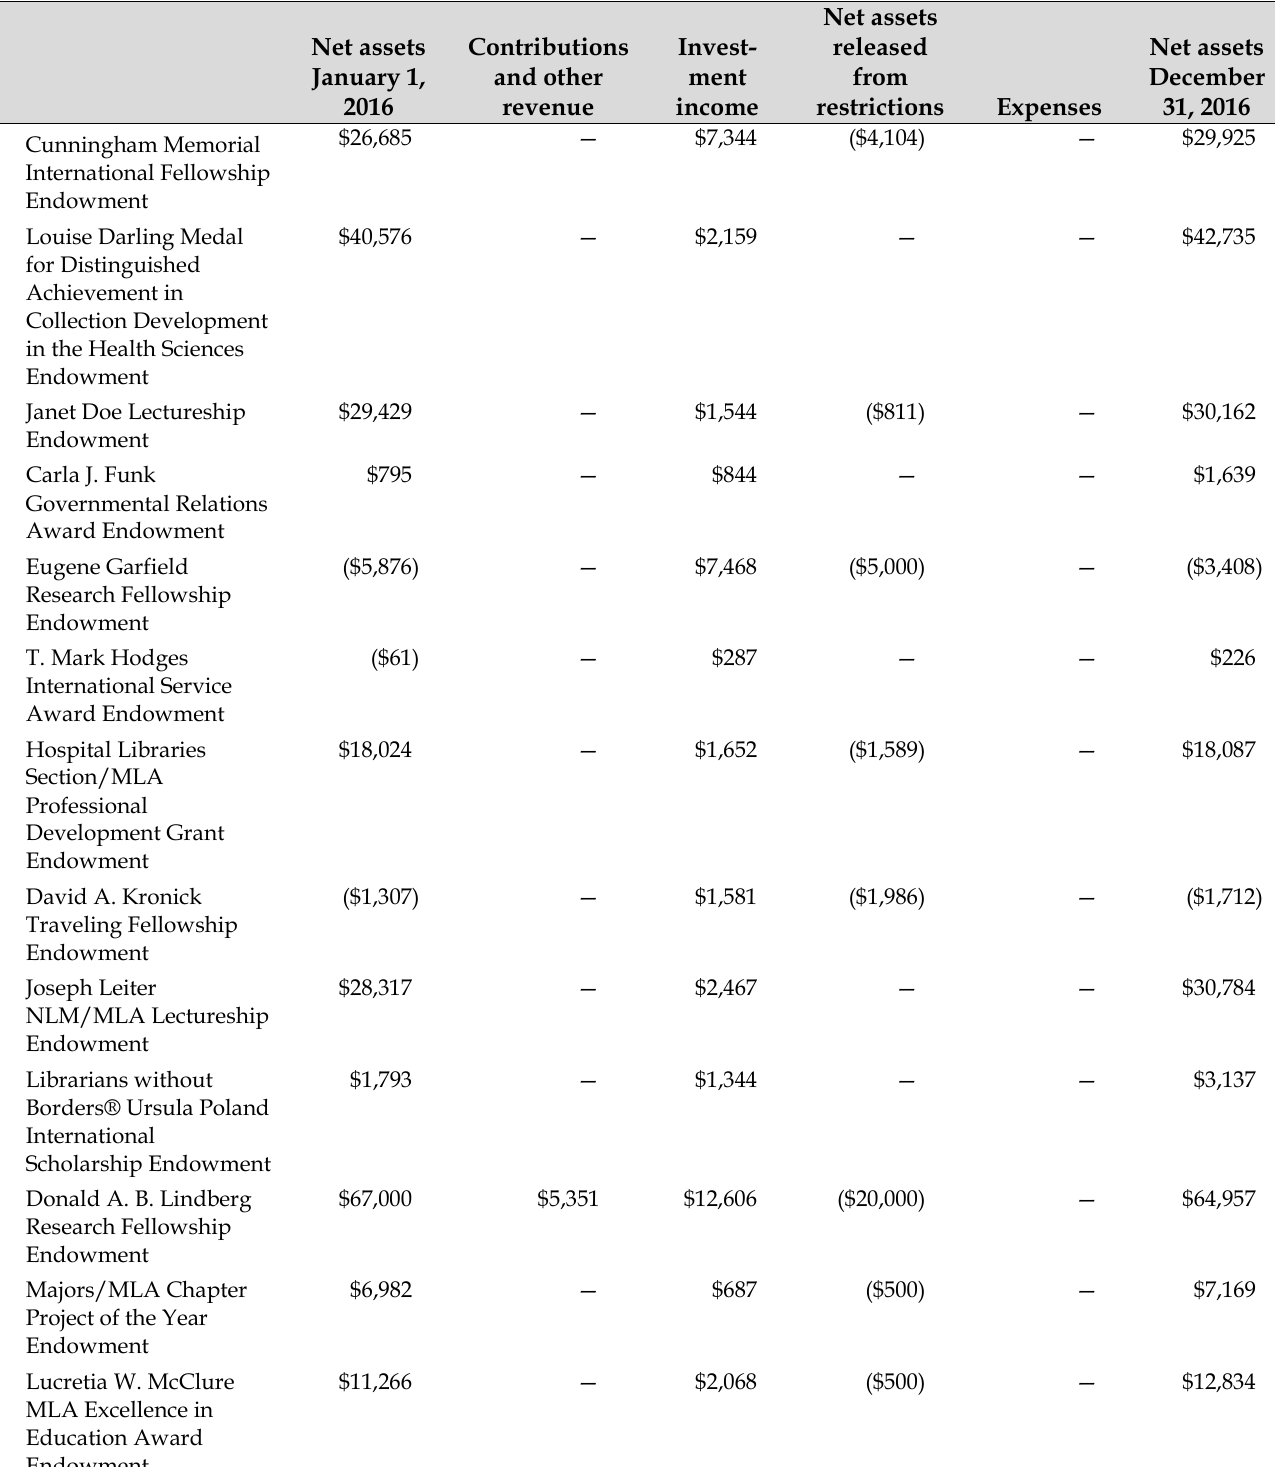
Table 1 Medical Library Association schedule of changes in net assets by fund year ended December 31,